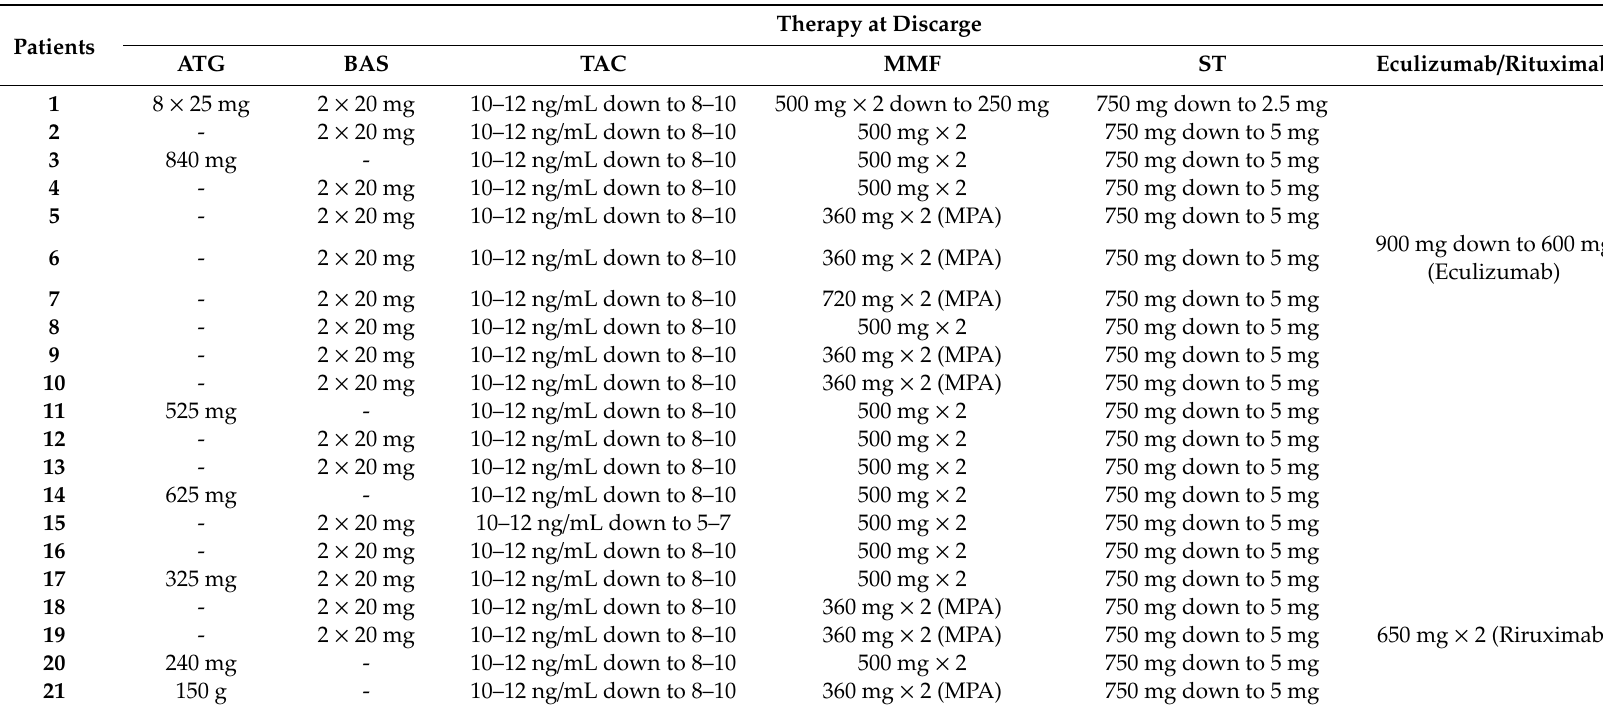
Table 1. Therapy at discharge. Anti-thymogobuline (ATG), Basiliximab (BAS), Tacrolimus (TAC), mycophenolate mofetil / mycophenolate (MMF / MPA), and steroids